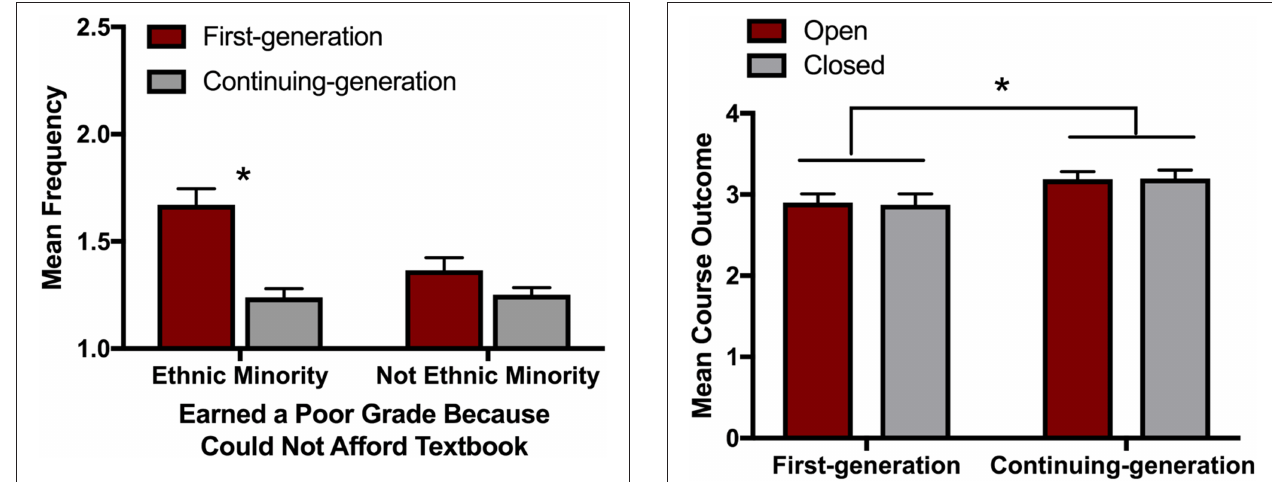
FIGURE 4 | Course performance across textbook groups and first-generation status. Bars depict means, error bars represent standard errors of the mean, *indicates p <